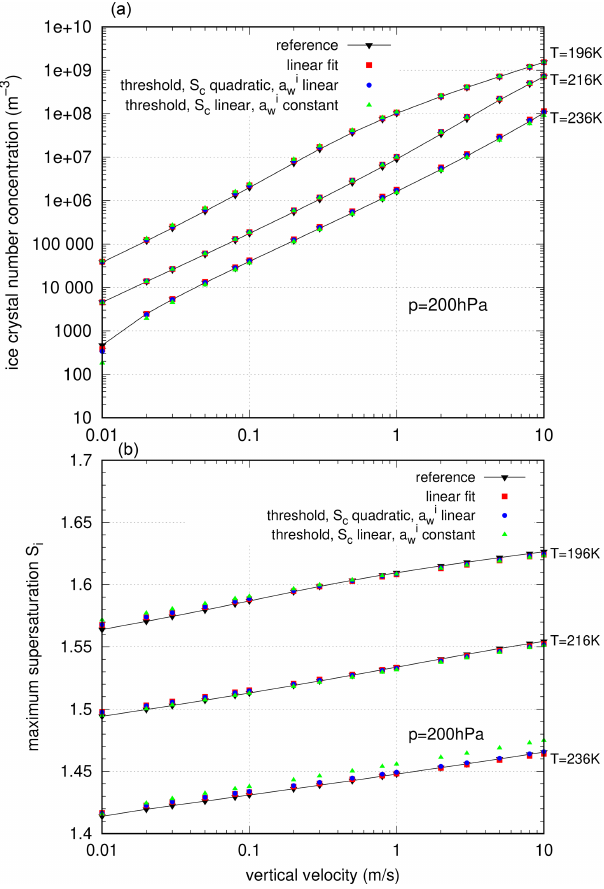
Figure 4. Comparison of different approximations of the nucleation rate by Koop et al. (2000) for standard nucleation events driven by a constant vertical velocity w . (a) Ice crystal number concentration and (b) maximum